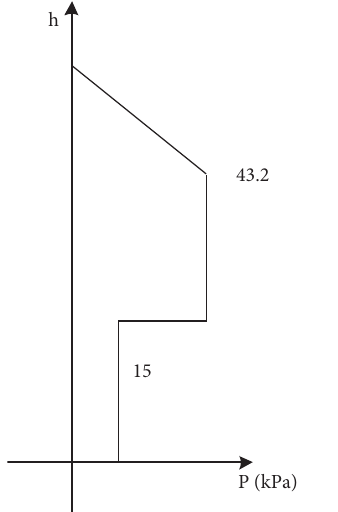
Figure 1: Distribution of concrete lateral stress.